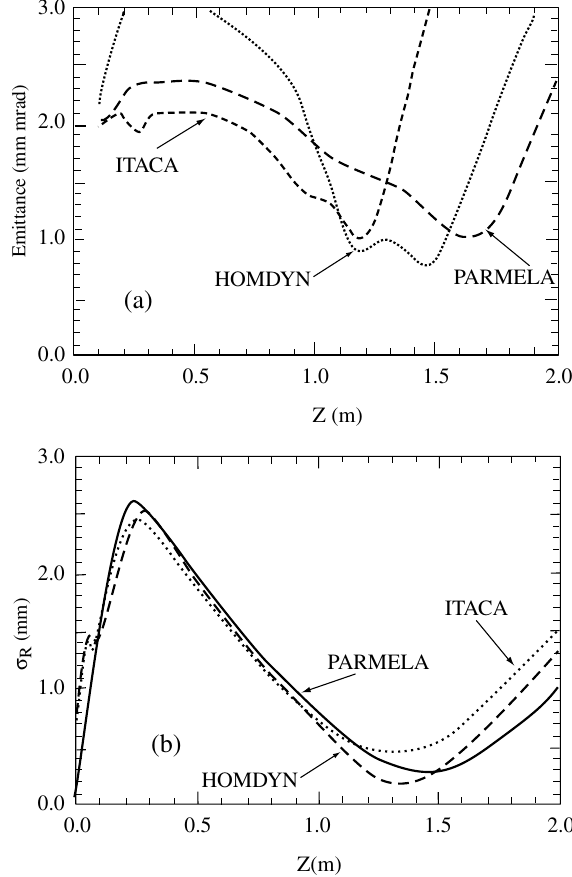
FIG. 4. Comparison between ITACA , PARMELA , and HOMDYN obtained in a standard split injector configuration as the one shown in Fig. 2. The behaviors of the normalized emittance and of the beam rms envelope versus the longitudinal coordinate are shown in (a) and (b),